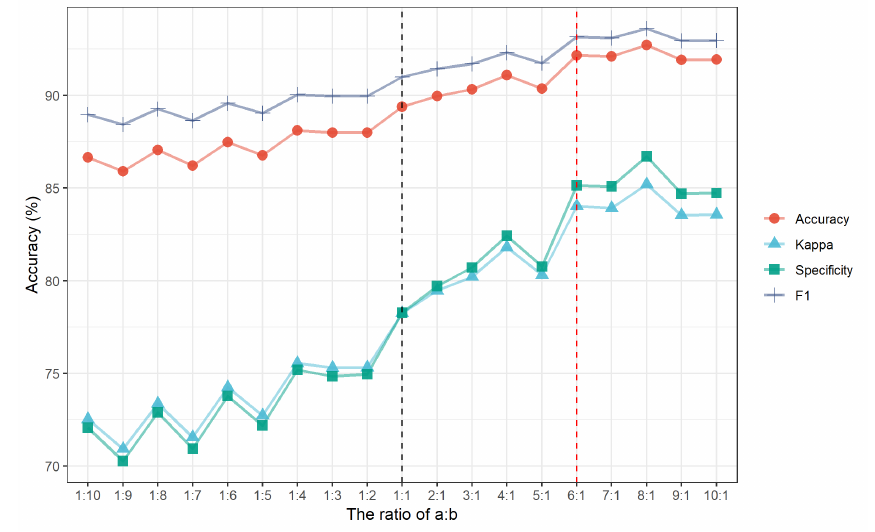
Figure 15. The accuracy respond to different ratios of the ellipse searching